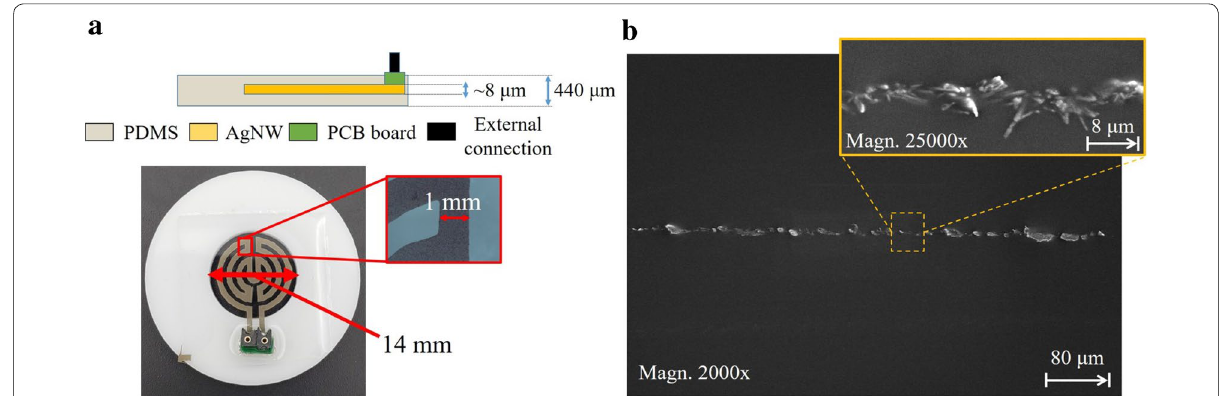
Fig. 6 a Final configuration of the optimized sensor showing a total thickness of 440 μm, 8 μm-thick AgNW layer, pattern strip width of 1 mm, connecting module’s inner diameter of 14 mm. b Scanning electron microscope (SEM) images of the cross-section of the sensor magnified by 2000 and 25,000 times. The AgNW layer is sandwiched by upper and lower layers of